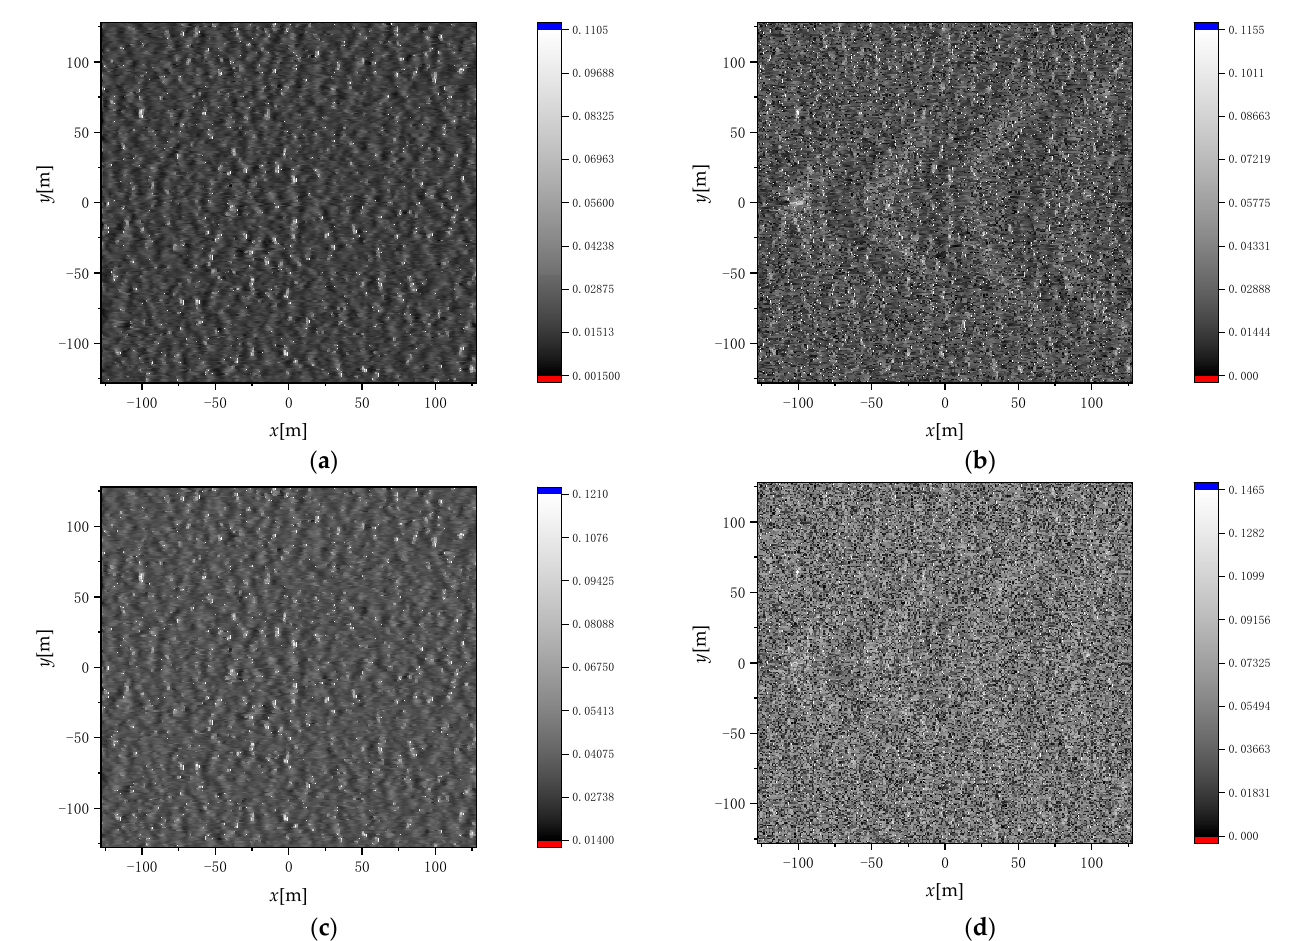
Figure 10. Surface element scattering distribution: ( a ) and ( b ) for HH polarization; ( c ) and ( d ) for VV polarization.